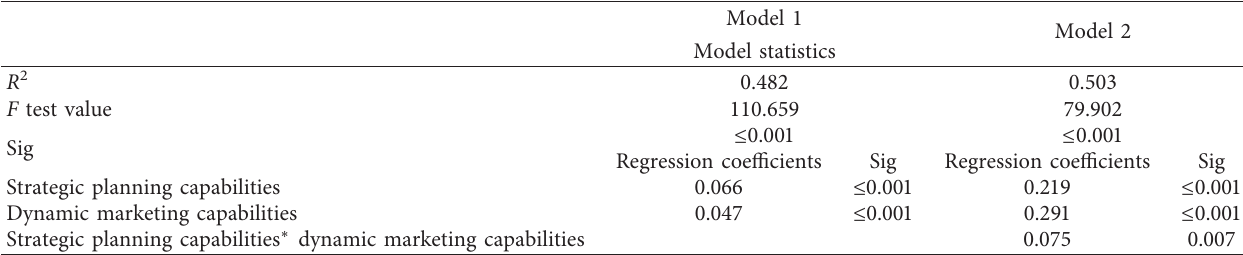
Table 5: Analysis of the adjustment effect of dynamic marketing capabilities (strategic planning capabilities ➔ sustainable competitive advantage).